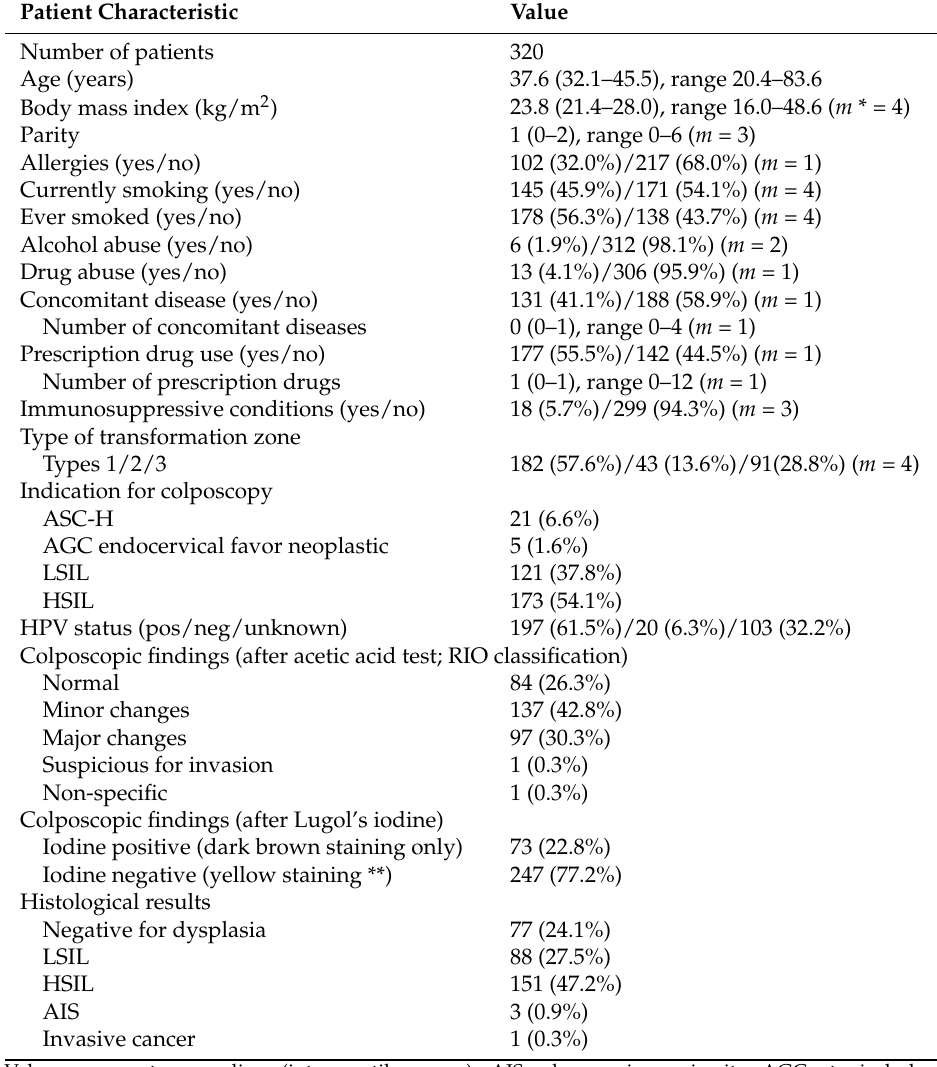
Table 1. Patient characteristics, colposcopy, and